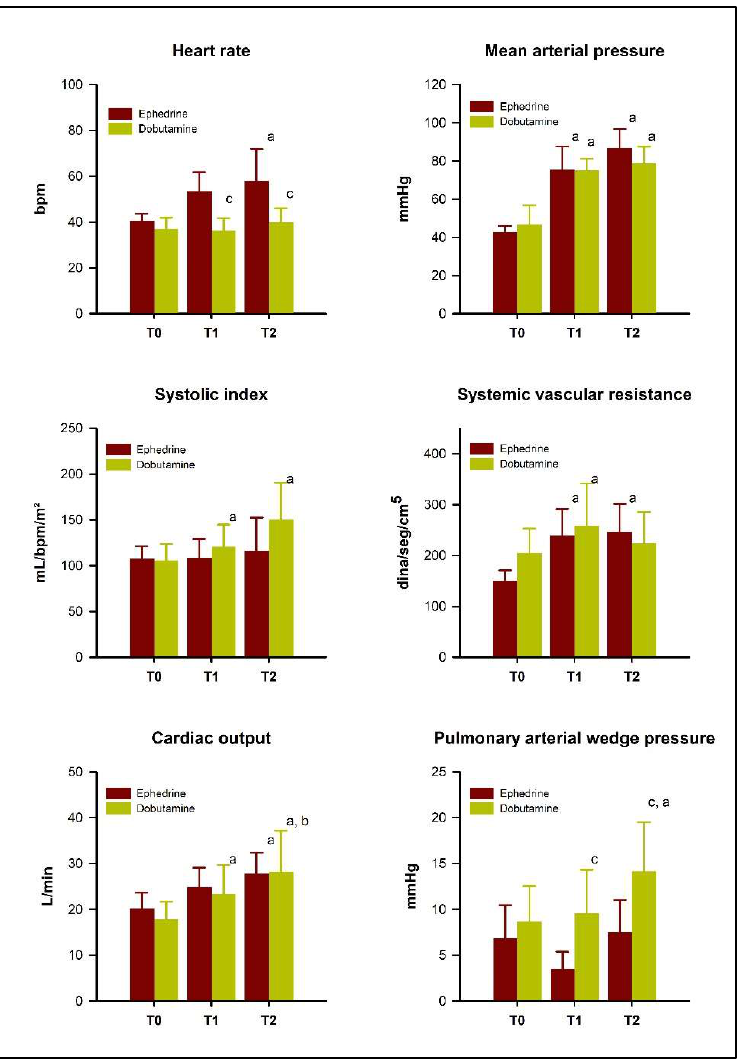
Figure 1. Changes in heart rate, mean arterial pressure, systolic index, systemic vascular resistance, cardiac output, and pulmonary arterial wedge pressure in 13 isoflurane-anesthetized horses treated with dobutamine or ephedrine, measured at the time of the detection of hypotension (T0), upon reaching a mean arterial pressure of 70 mmHg (T1), and 15 min after T1 (T2). Superscript letters indicate a significant difference ( p < 0.05) from the basal moment (a), from goal moment (b), or from the other group in the same moment (c).